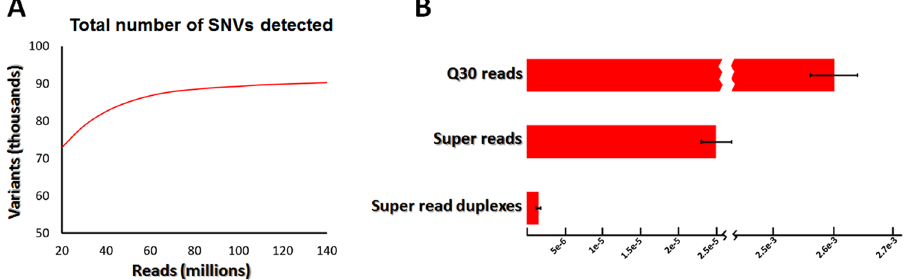
Figure 5. SNV-calling trends and statistics of DEEPER-Seq WES study. ( A ) Total number of SNVs detected at increasing read count thresholds. Sensitivity increases at higher read counts but quickly reaches a plateau with more than 80 million reads. ( B ) Average SNV frequencies of normal tissue DNA measured by three approaches: a standard NGS approach where barcodes were directly trimmed off, a super read based approach by DEEPER- Seq without matching variants from both DNA strands (without the last step of the 4-step procedure), and a super read approach by DEEPER-Seq matching the SNV on both strands (all steps in the 4-step procedure were performed).